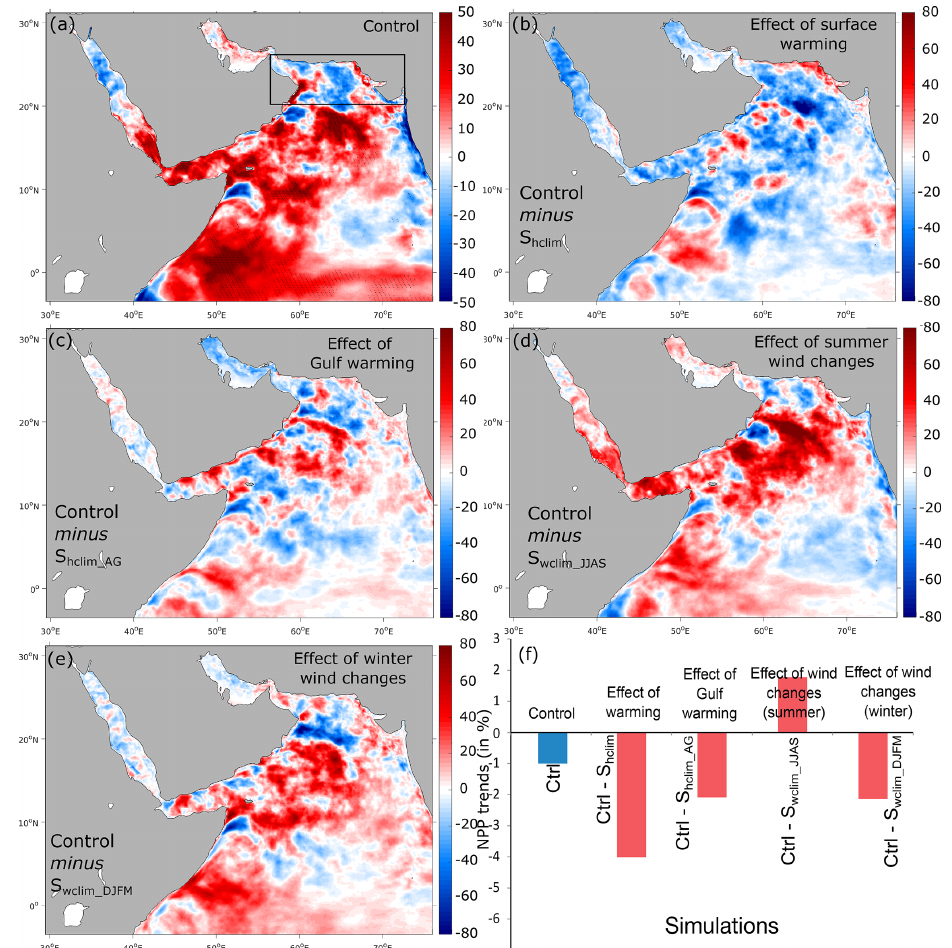
Figure 12. Effects of different atmospheric forcing perturbations on net primary production (NPP). (a) Linear trends in NPP in the control run (in molm − 2 yr − 1 per decade). (b–e) Difference in NPP trends between the control run and the S hclim (i.e., effect of warming), S hclim_AG (i.e., effect of Gulf warming), S wclim_JJAS (i.e., effect of summer wind intensification) and S wclim_DJFM (i.e., effect of winter wind